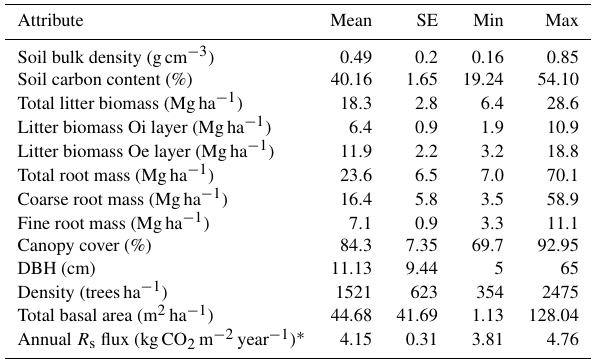
Table 2. Characteristics of the forest stand, soil (30cm) and annual R s flux ( n = 3).